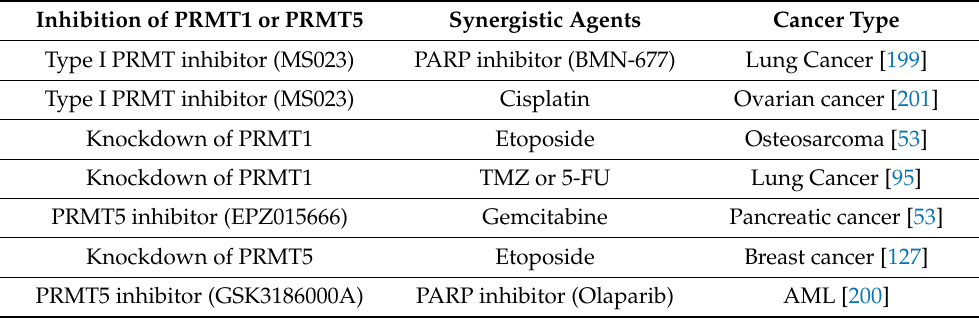
Table 2. Inhibition of PRMT1 or PRMT5 synergizes with PARP inhibitors or DNA damaging agents. Inhibition of PRMT1 or PRMT5 Synergistic